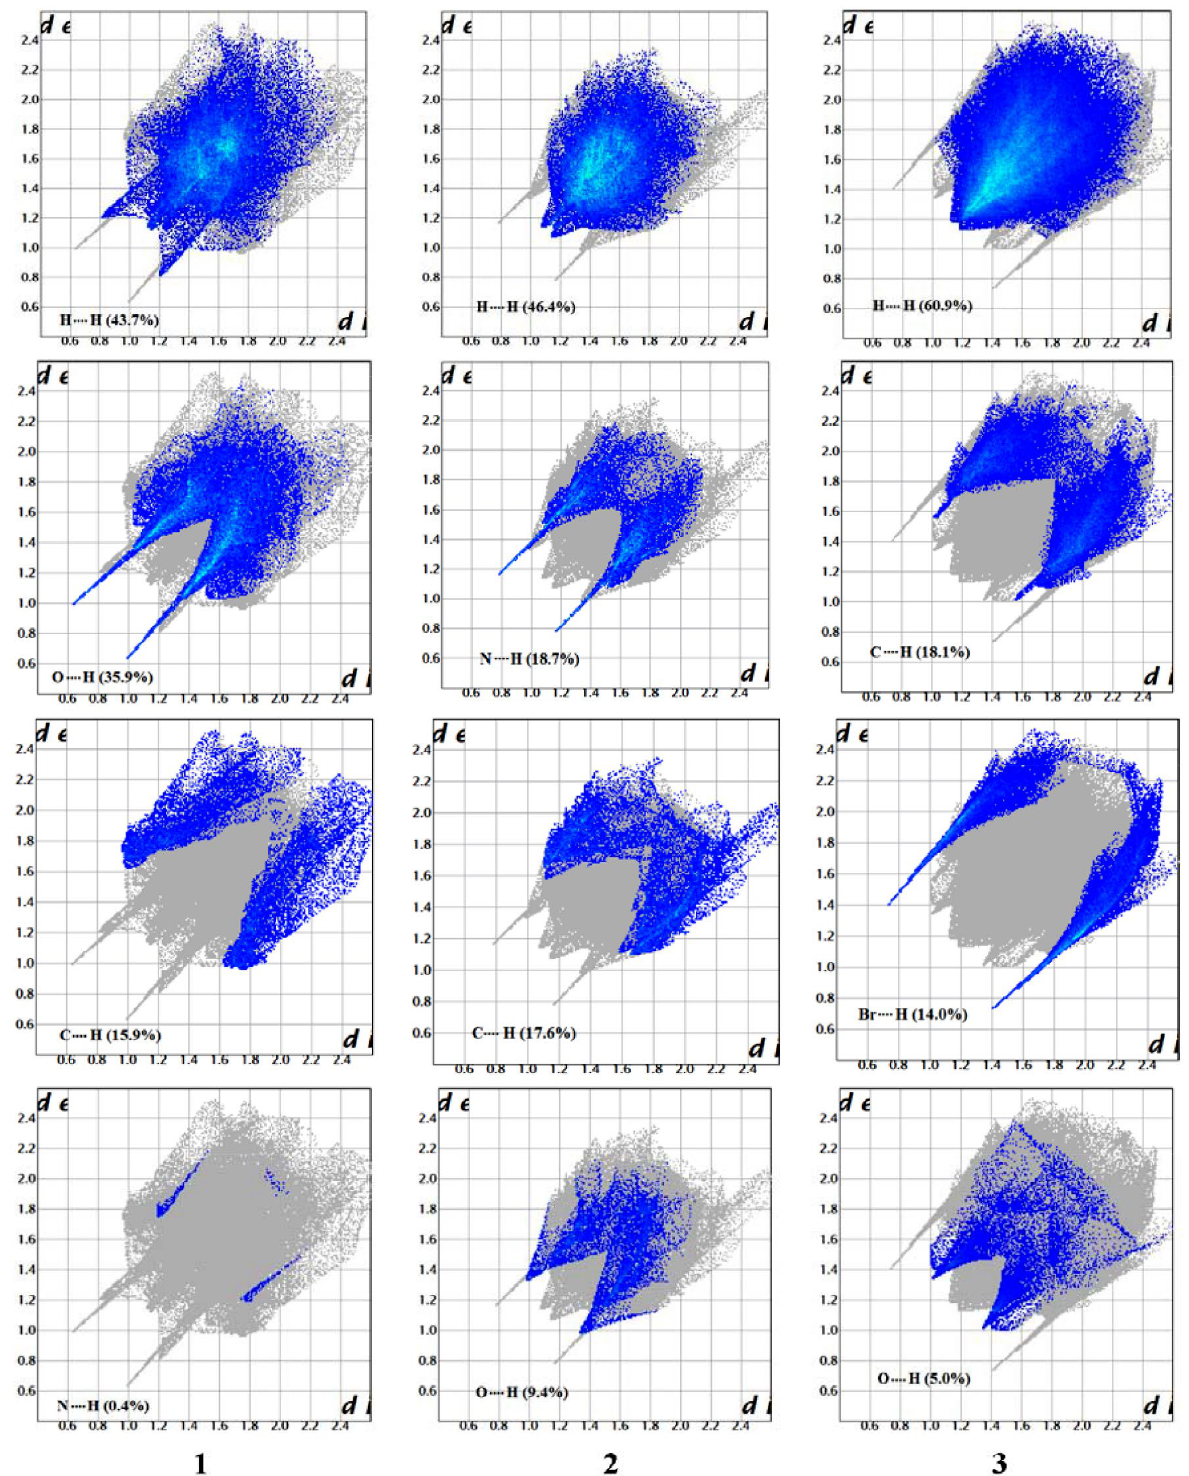
Fig. 6. The 2D fingerprint plots and relative contributions to the percentage of Hirshfeld surface for various interactions in 1–3